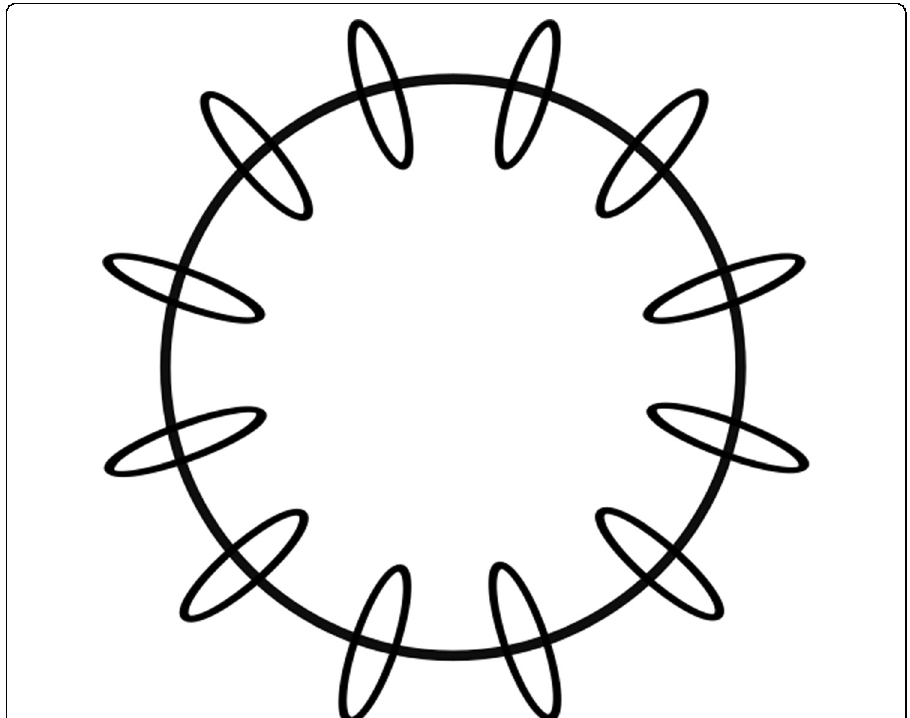
Fig. 5 Legend: The rings present EMMAs associates, as they are collectively shaping, working on and connected through the boundary as a shared